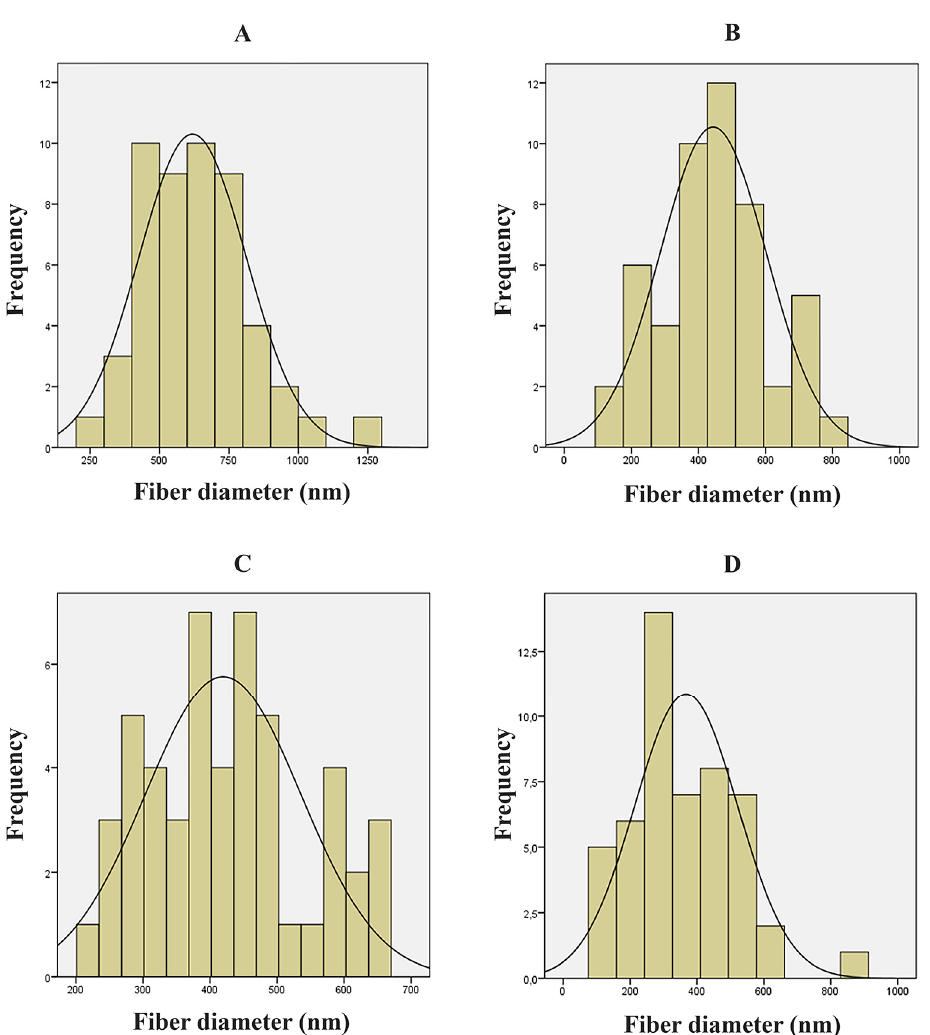
Figure 5. Distribution of fiber diameters. ( A ) HPC-PVP = 5:5 molar ratio; average diameter: 618.76 ± 193.617 nm; ( B ) HPC-PVP = 6:4 molar ratio; average diameter: 443.89 ± 158.376 nm; ( C ) HPC-PVP = 7:3 molar ratio; average diameter: 419.43 ± 116.048 nm; ( D ) HPC-PVP = 8:2 molar ratio; average diameter: 367.50 ± 153.908 nm.